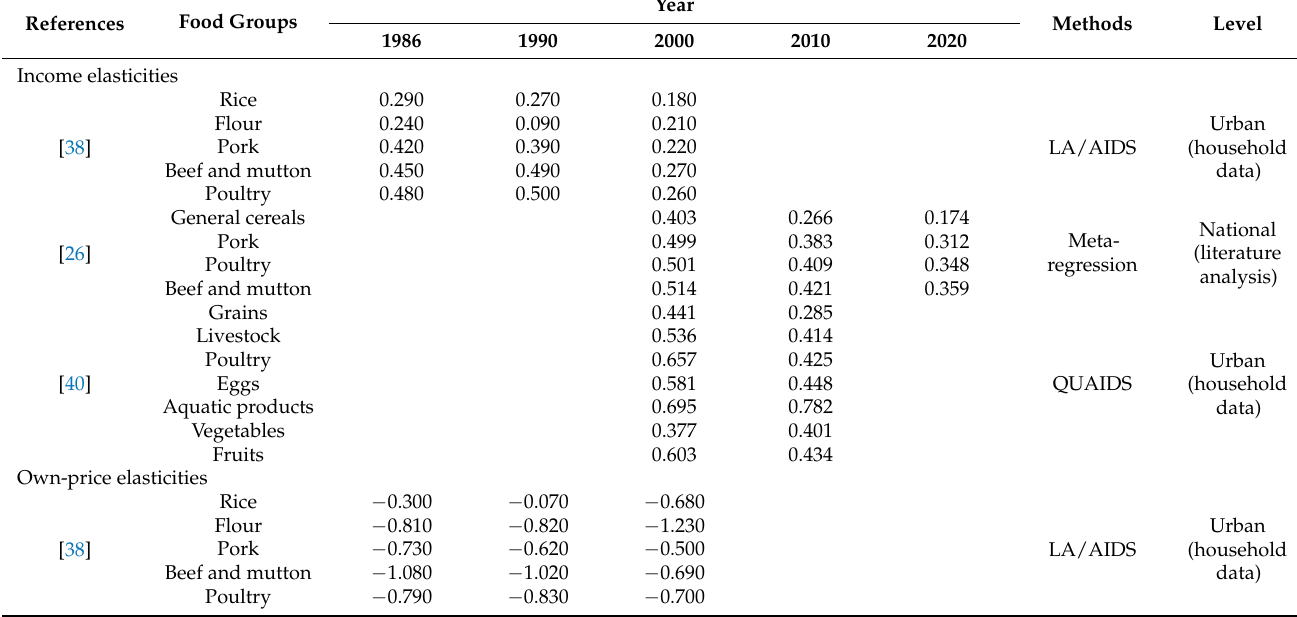
Table A2. The Change Trends of Income and Own-Price Elasticities in Previous